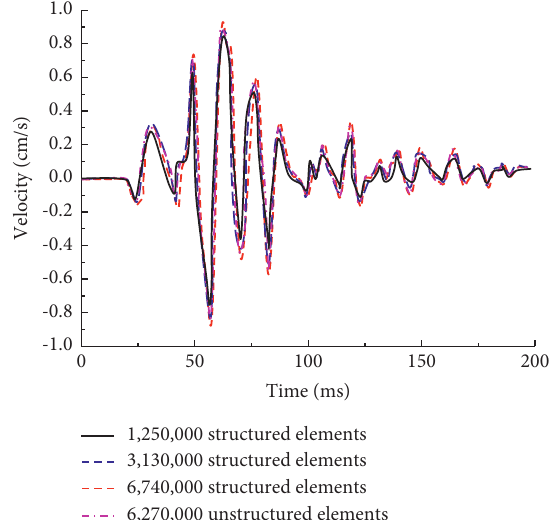
Figure 13: Vibration velocity-time curves under different discretizations.